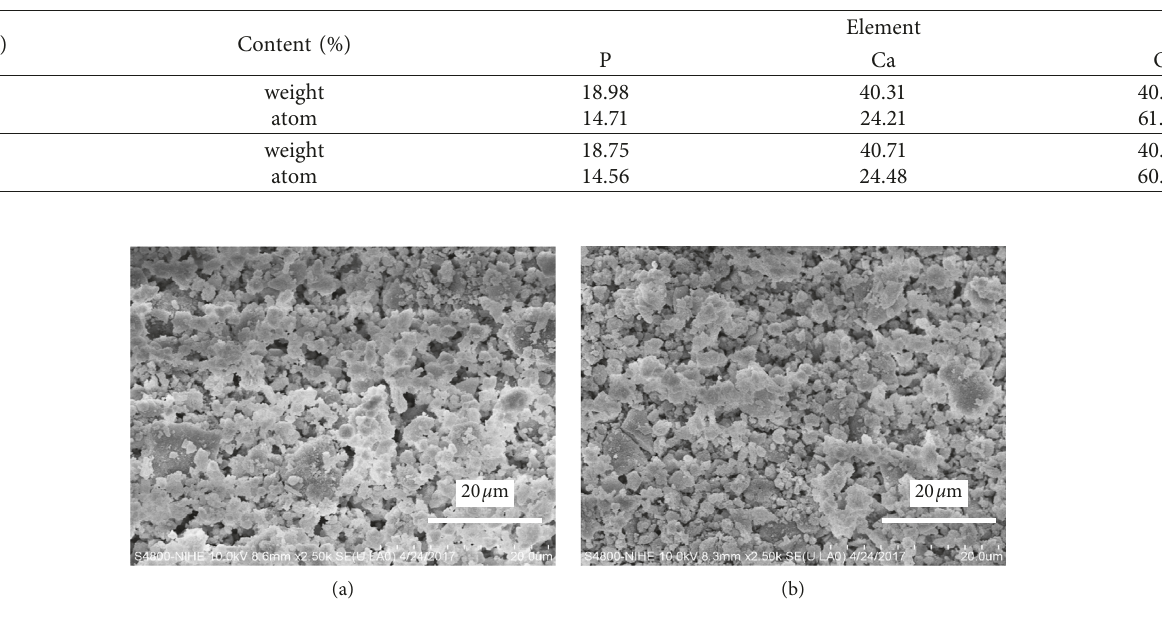
Table 3: Component of elements in H